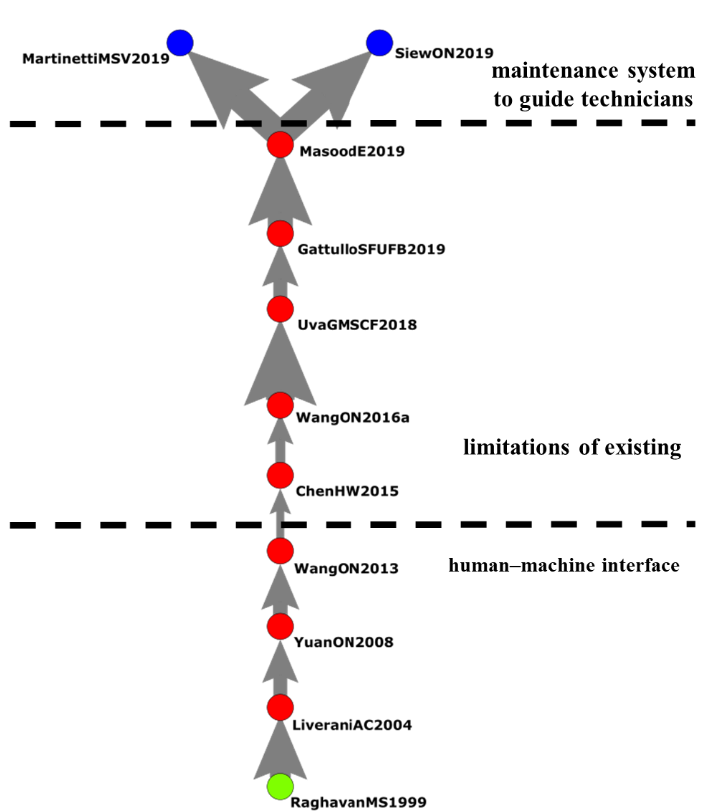
Figure 7. Application of AR technology in education.